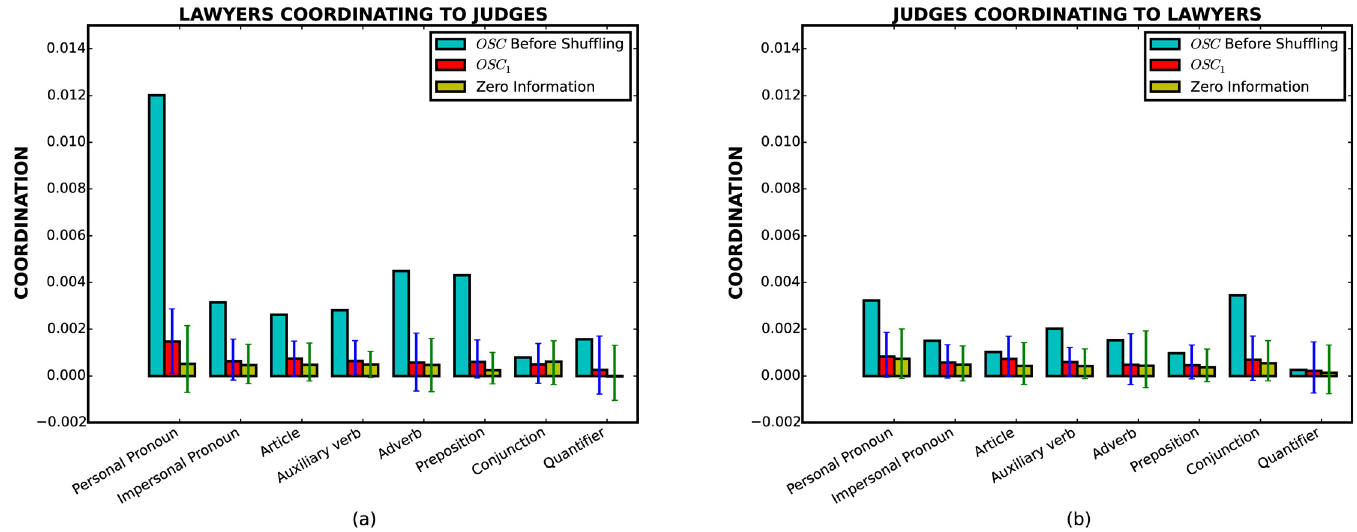
Fig 6. Turn-by-turn stylistic coordination test for Supreme Court data. (a) Lawyers coordinating to Judges. (b) Judges coordinating to Lawyers. (Blue bars indicate the overall stylistic coordination( OSC ) before the test). One can see that after shuffling, values of OSC 1 are within the zero-information confidence